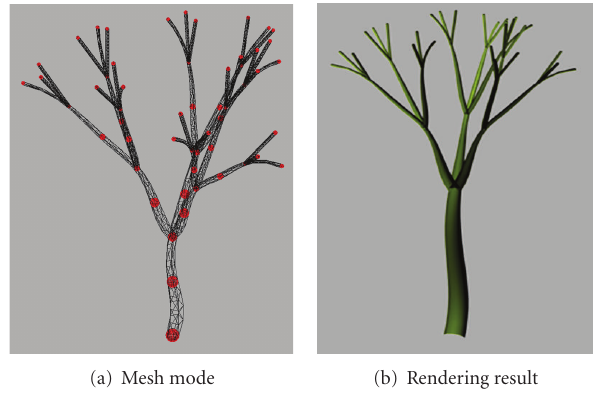
Figure 3: Tessellated BBSC-based tree.